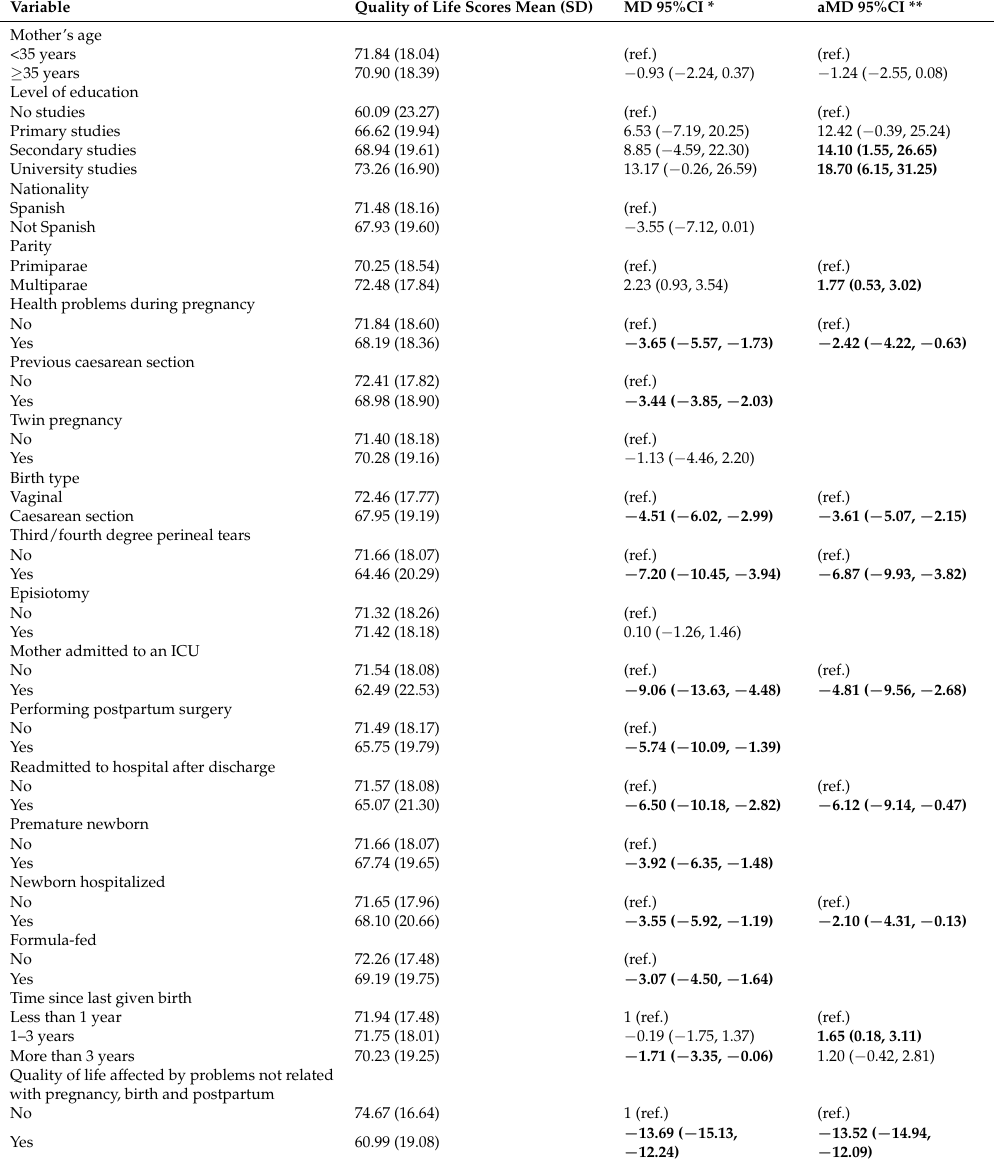
Table 3. Factors associated with postpartum quality of